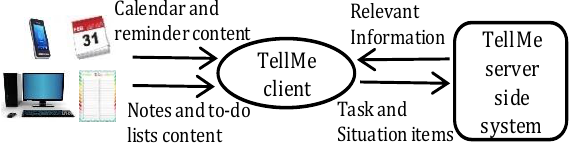
Figure 1: Overview of the TellMe